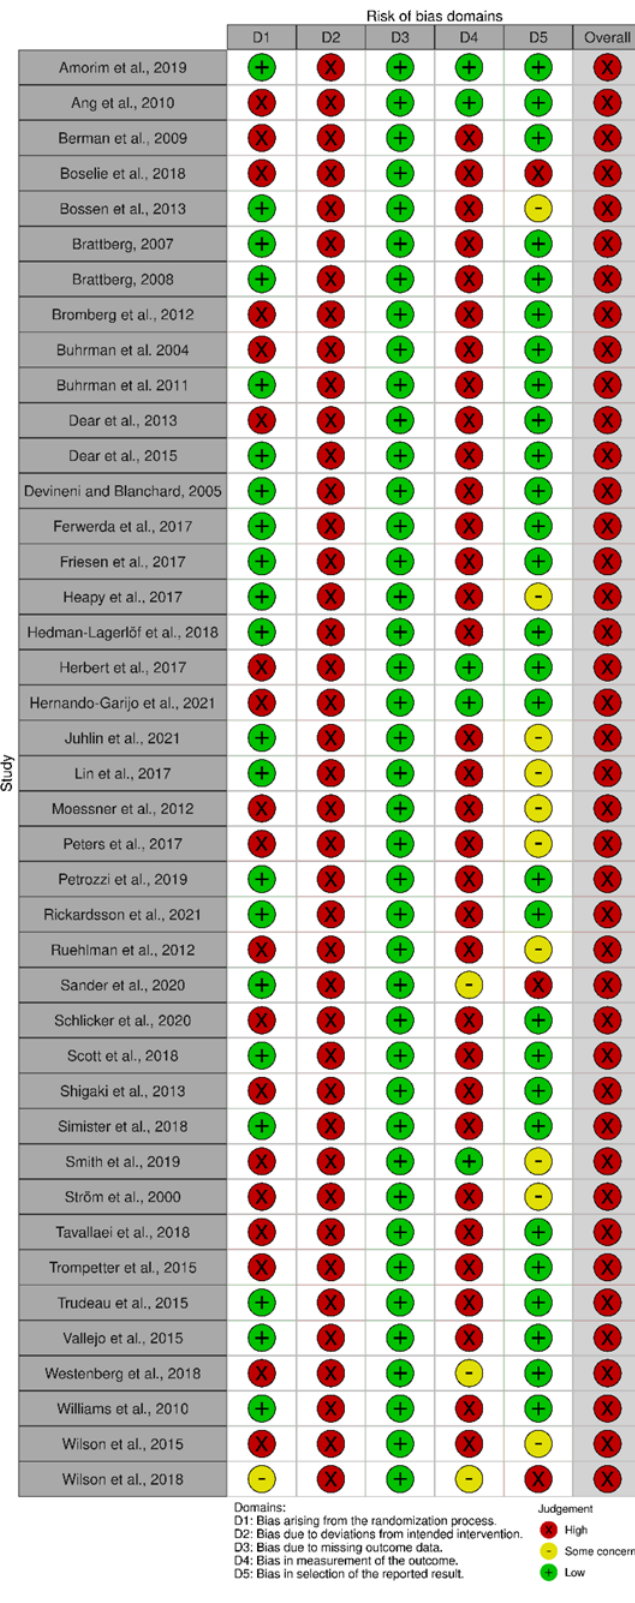
Figure A2. Risk of Bias 2.